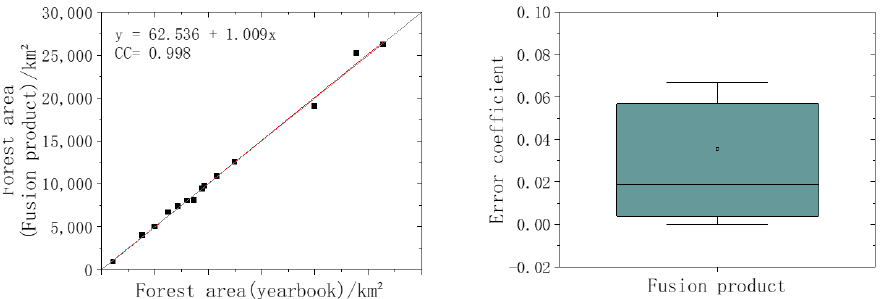
Figure 14. Comparison between city-level forest data and yearbook data for Guangxi with box plots of the corresponding relative errors.